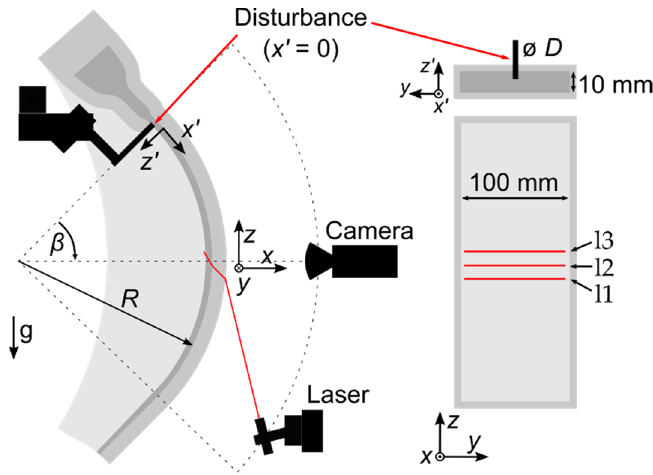
Figure 4. Sketch of the FIDES test section showing the position of the measurement system (camera and laser) and the position of the disturbance with the diameter, D . The test section is a concave open channel with a curvature radius of R = 250 mm. The measuring position is described by the angle β . On the right side, the view on the back wall of the test section with the three reflected lines l1, l2 and l3 is shown.